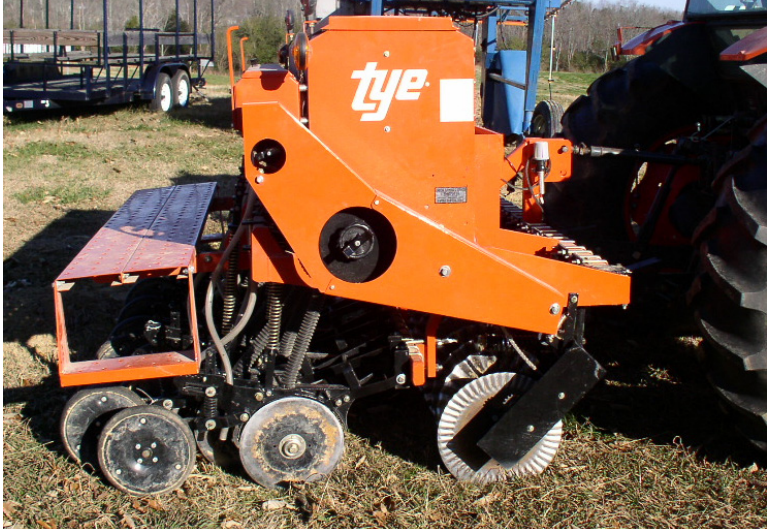
Figure 2. TYE Grain Drill Model No.: 124-530X, AGCO, Duluth, GA, USA.